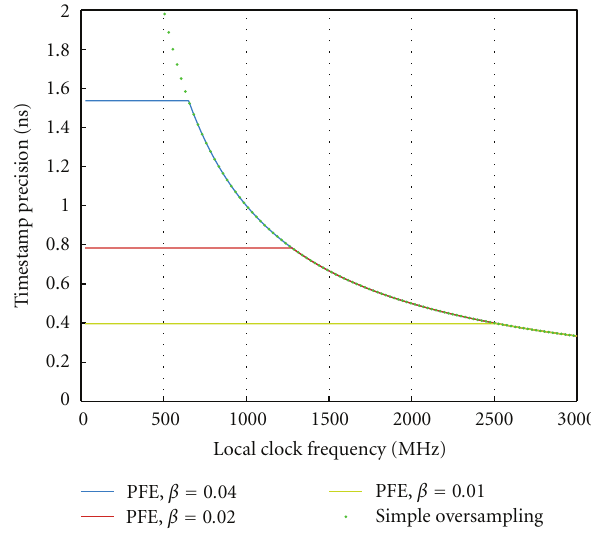
Figure 7: Timestamp precision with a 25MHz communication clock for the PFE approach and simple